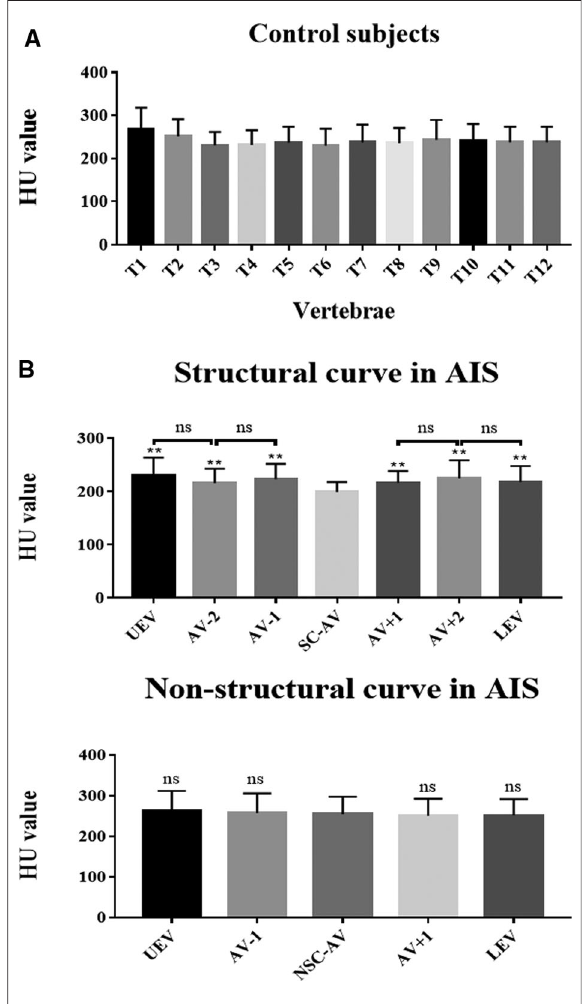
FIGURE 3 Vertebral-body bone quality of the apical region of the structural curve was decreased in AIS patients. ( A ) HU value of thoracic vertebral bodies from T1 to T12 in controls. ( B ) HU value of different levels of vertebral bodies in AIS patients, including the structural and non-structural curves. Total 30 patients with Lenke type 1A AIS and 30 paired controls were included in this study. ns: no statistical signi fi cance; ** P <0.01 vs. SC-AV or NSC-AV